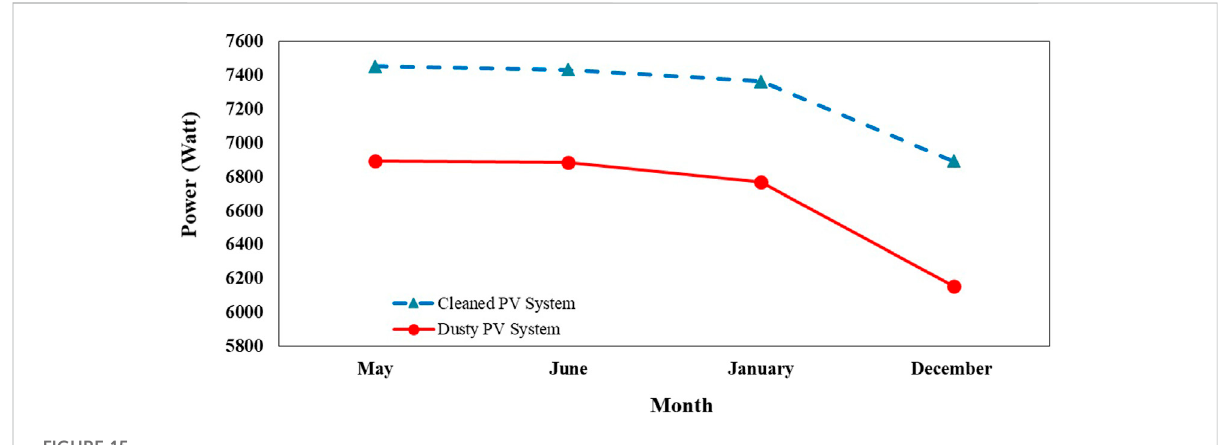
FIGURE 15 PM concentration impact on photovoltaic energy